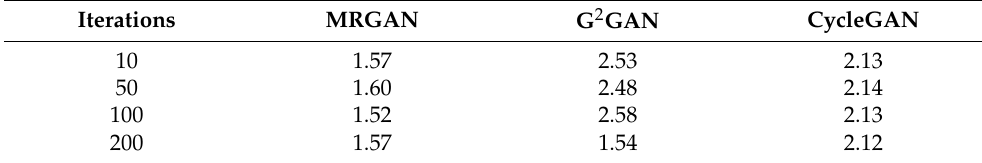
Table 1. Average time consumption under different training iterations (s).